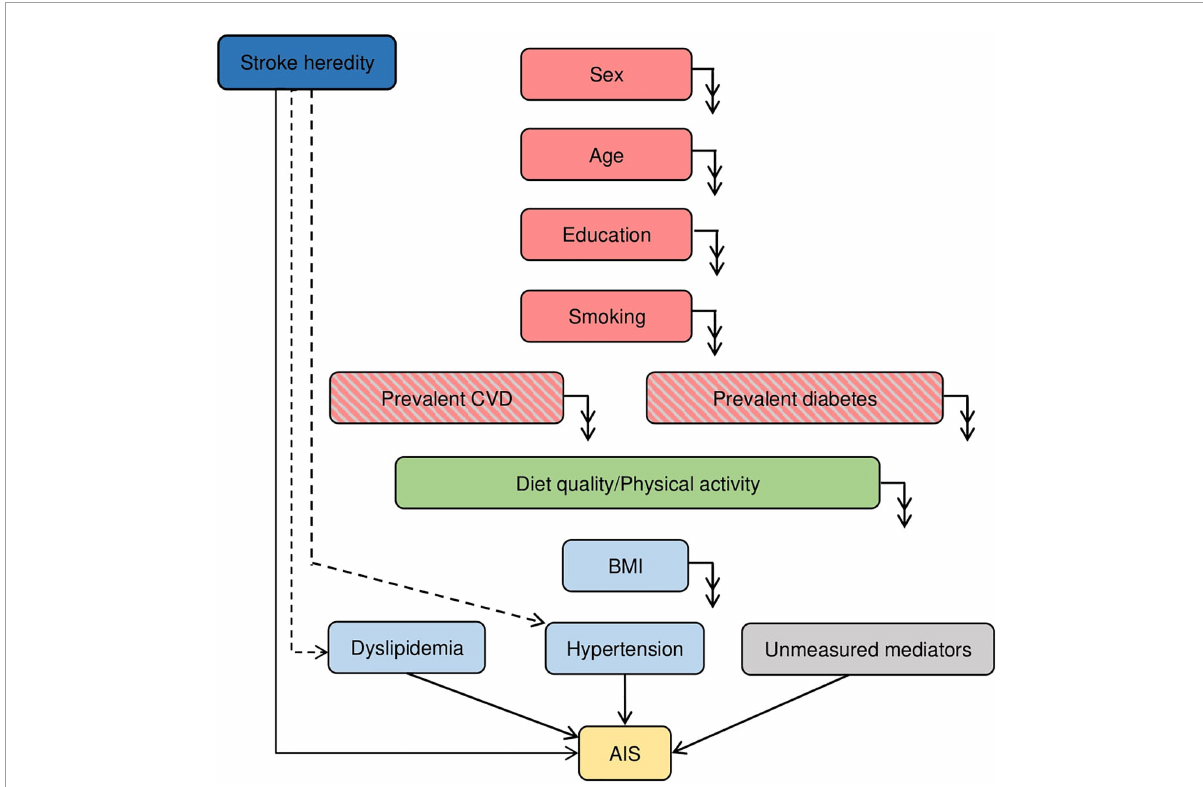
FIGURE1 Directed Acyclic Graph (DAG) derived from the literature and expert knowledge of the MDCS cohort. Nodes represent variables and arrows represent causal associations. Double arrows indicate effect on all downstream variables. Dashed arrows indicate potential effect. Red colored variables represent confounding factors, light blue colored variables represent mediating factors, light gray colored variables represent mediating factors not included in study and dark blue colored variables represent competing exposure for the association between diet quality and PA (exposure, green colored) on the risk of atherothrombotic ischemic stroke (AIS, outcome, yellow color). Red and gray colored variables are excluded in the present